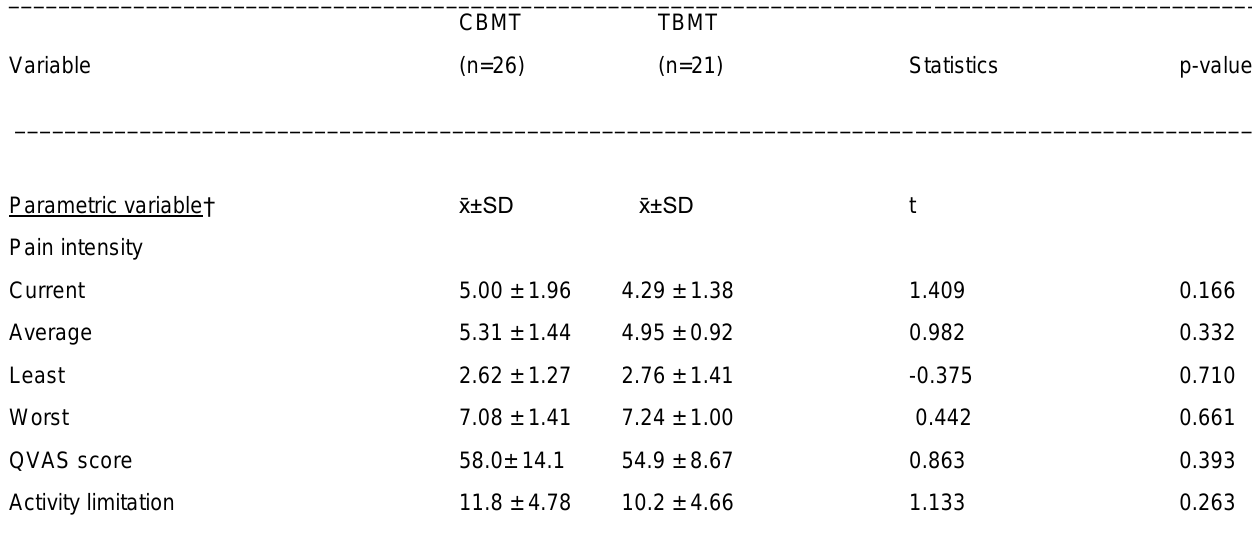
Table 3. Comparison of the Participants’ Baseline